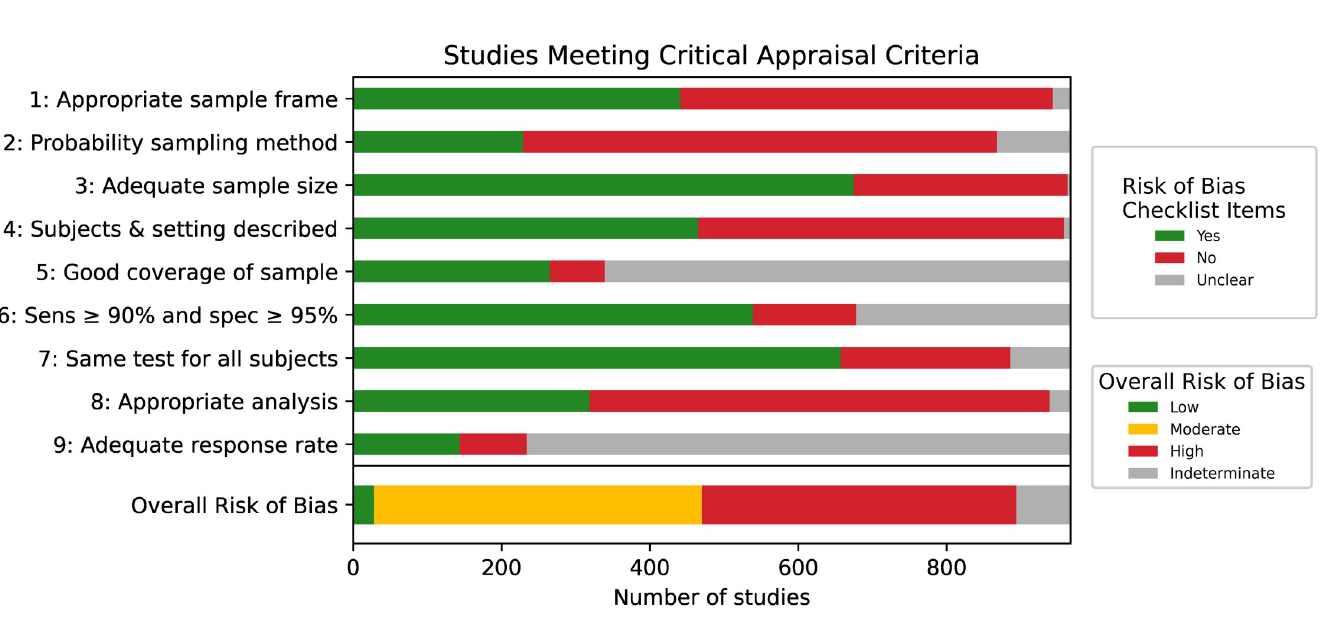
Fig 3. Study risk of bias summary. Item 1: Was the sample frame appropriate to address the target population? Item 2: Were study participants recruited in an appropriate way? Item 3: Was the sample size adequate? Item 4: Were the study subjects and setting described in detail? Item 5: Was data analysis conducted with sufficient coverage of the identified sample? Item 6: Were valid methods used for the identification of the condition? Item 7: Was the condition measured in a standard, reliable way for all participants? Item 8: Was there appropriate statistical analysis? Item 9: Was the response rate adequate, and if not, was the low response rate managed appropriately? Item 10: Overall risk of